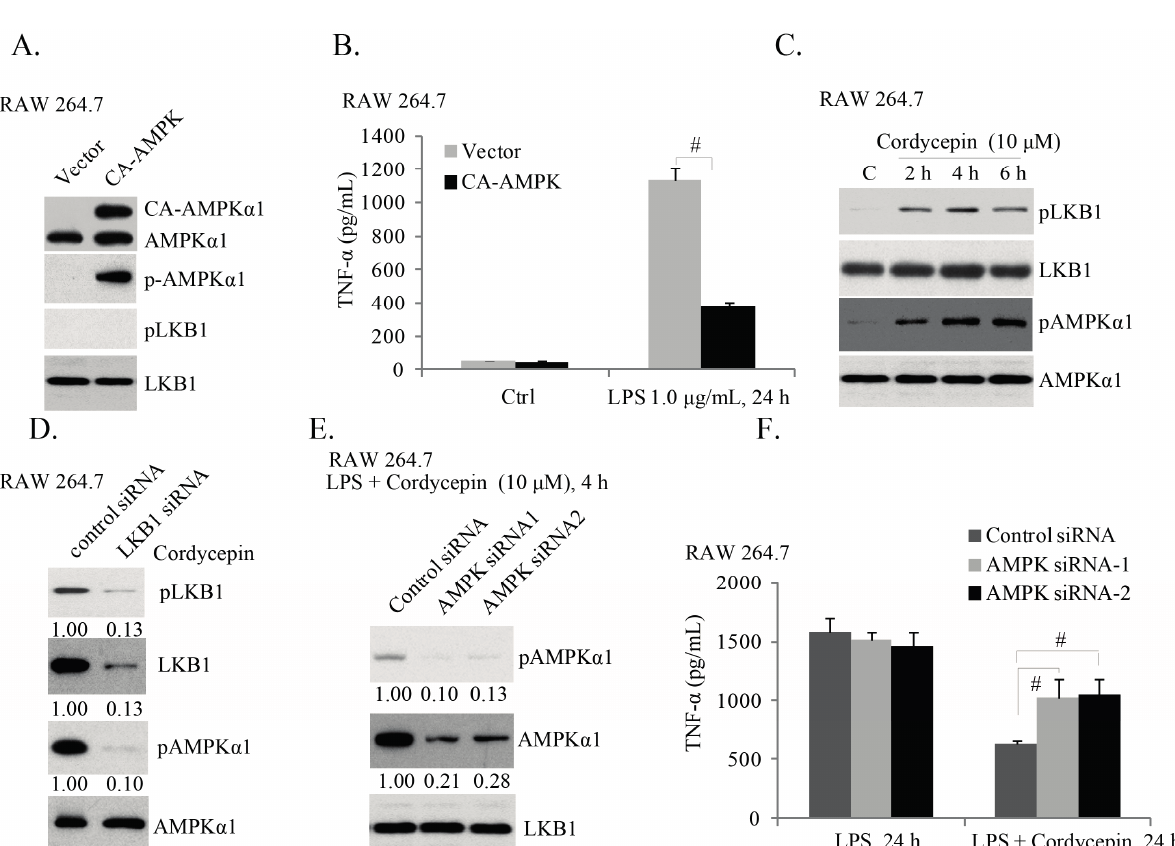
Figure 3. AMPK (AMP-activated protein kinase) activation is required for